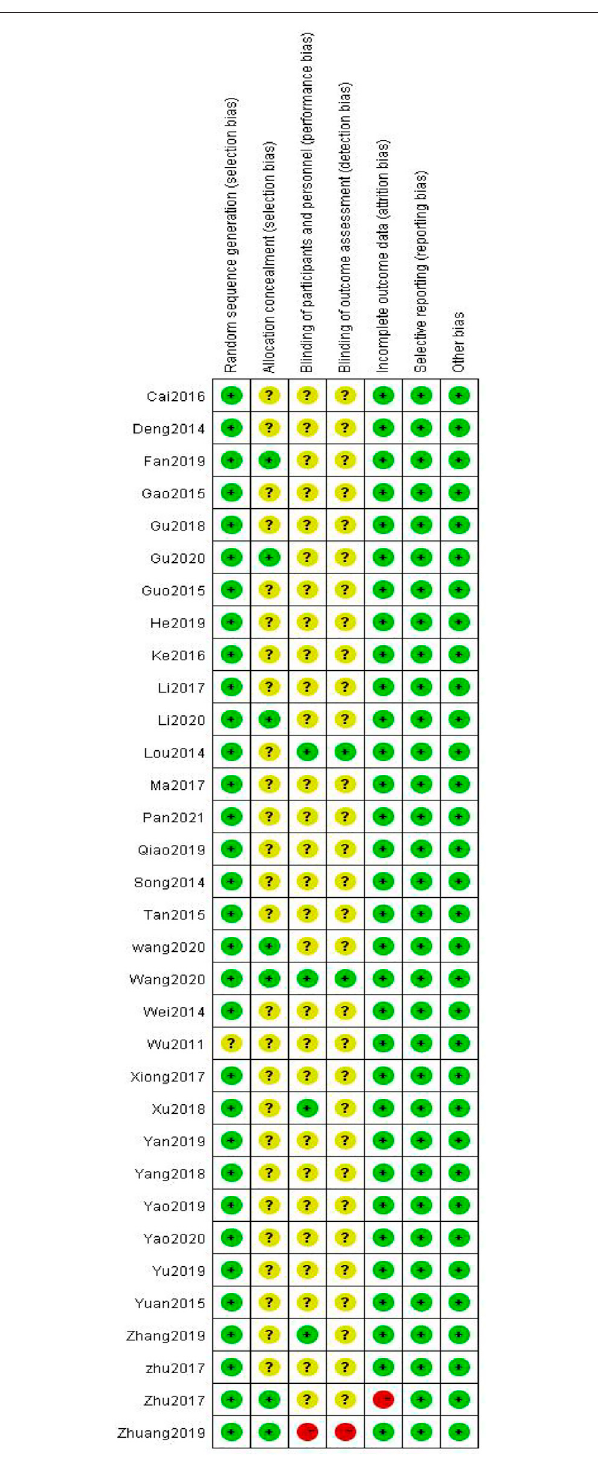
FIGURE 3 | Risk-of-bias